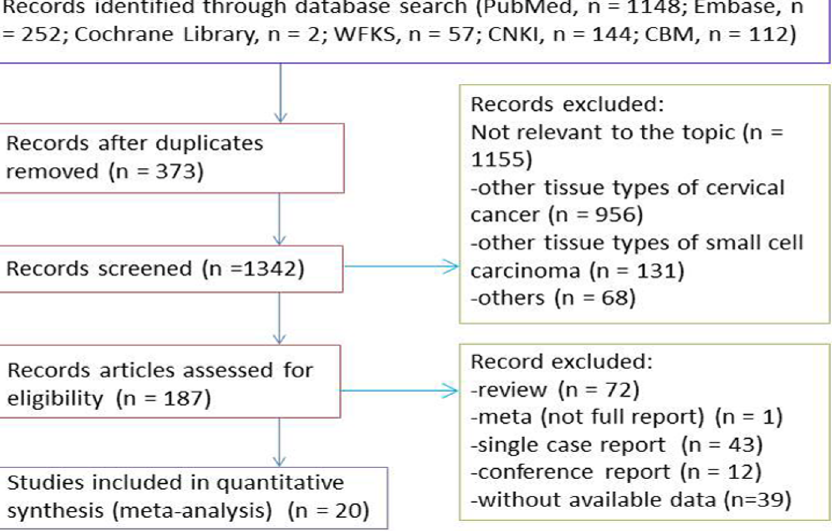
Fig 1. Studies eligible for inclusion in the meta-analysis. CKNI: China national knowledge infrastructure; CBM: China biology medicine.